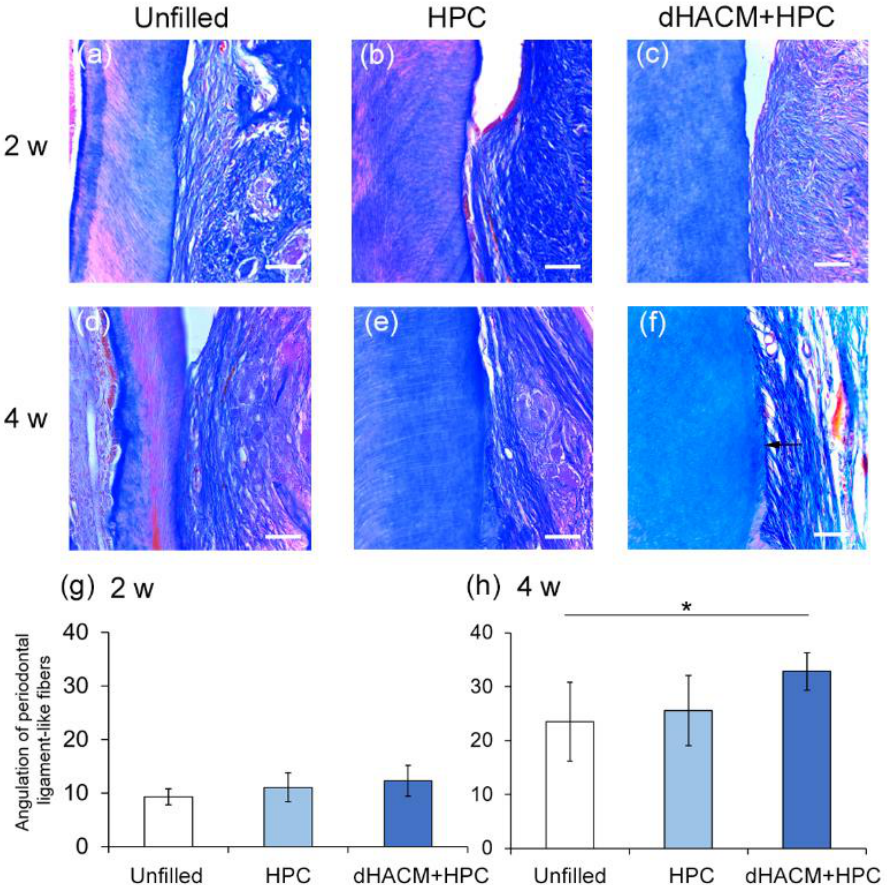
Figure 4. Healing of periodontal ligament (PDL). ( a – f ) Representative photomicrographs of the root area near the bottom of defect at 2 and 4 weeks. ( a – c ) At 2 weeks (upper panel), collagen bundles run near parallel to the surfaces in all groups. ( f ) At 4 weeks, PDL-like collagen bundles are well-aligned and obliquely inserted onto the root surface similar to native PDL with signs of thin-layer of cementogenesis (indicated by an arrow). (Azan–Mallory’s stain, original magnification × 200; bar = 50 µ m). ( g , h ) The angulation of the fibers at the bottom area of instrumentation on M1 root was observed under × 200 and analyzed by Image J software at 2 and 4 weeks. Data shown as mean ± SD ( n = 6) in degree. * p < 0.05 by ANOVA with Tukey post-test.